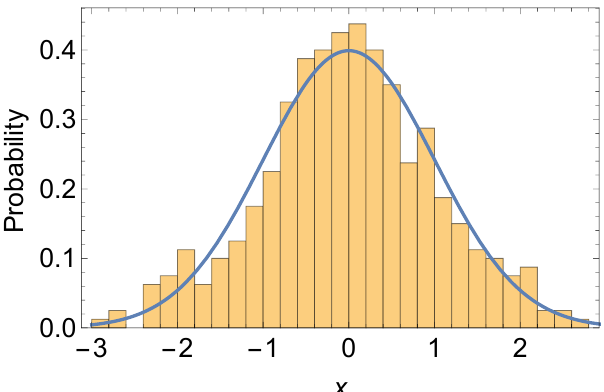
Figure 4. Histogram of 400 random numbers, sampling the Gaussian initial